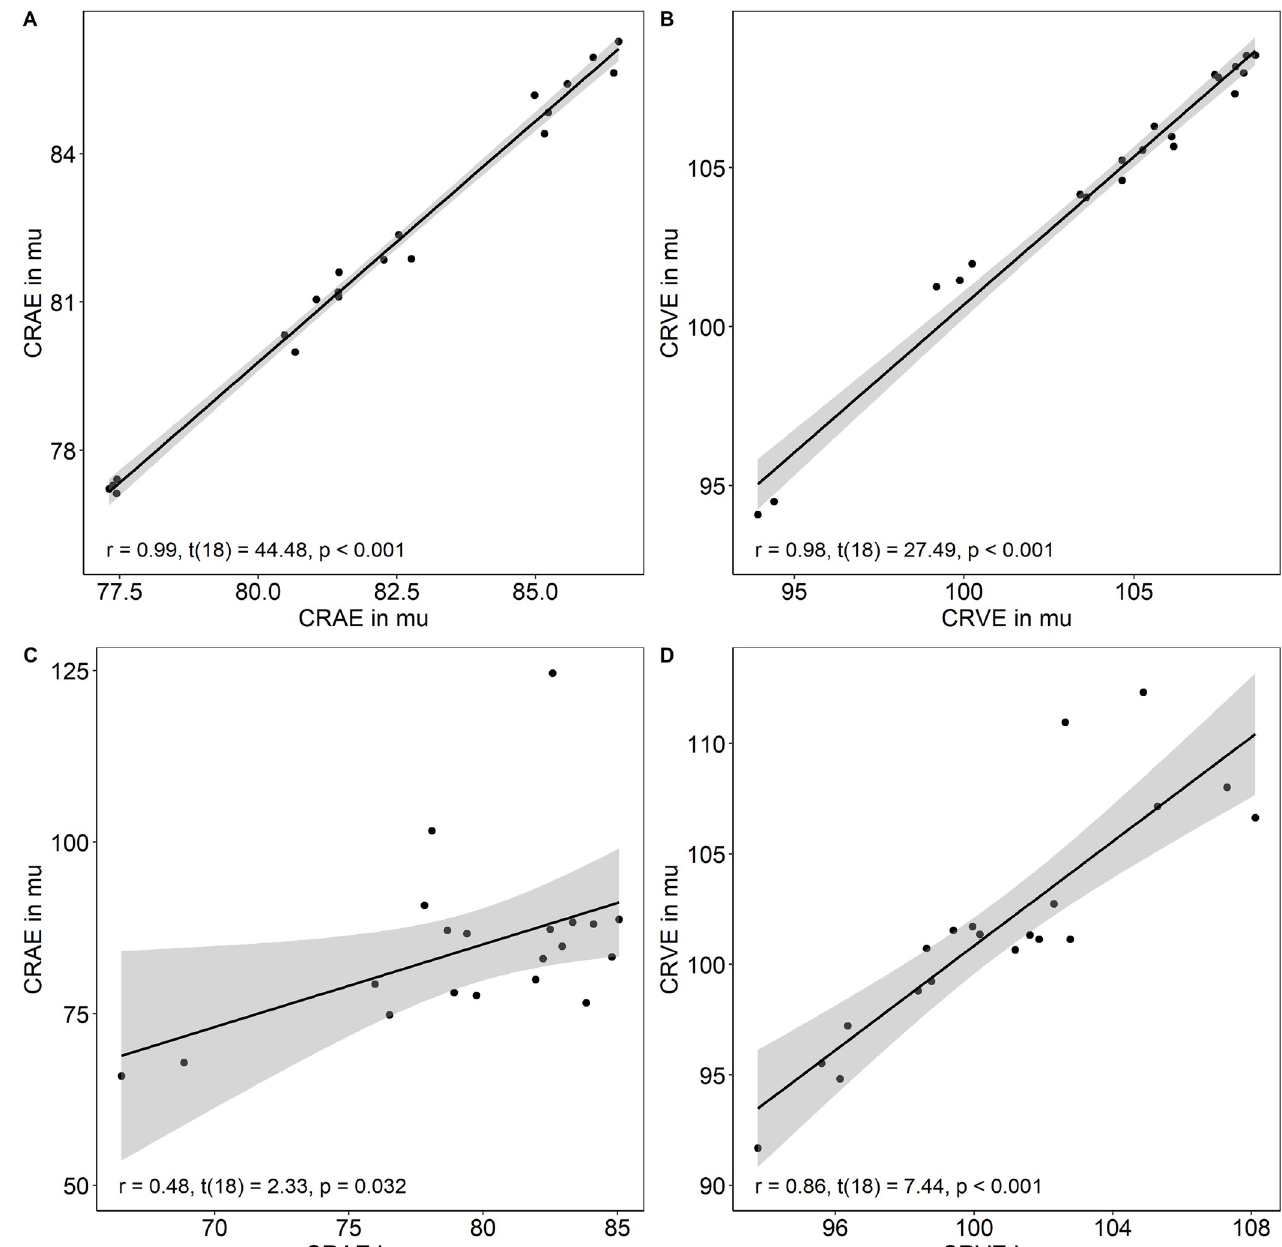
Fig 4. Intraobserver variability. Twenty images with (A and B) and 20 images without fluorescein (C and D) were analysed twice by one investigator to quantify intraobserver variability. Images were randomly selected. The intraobserver variability was analysed by calculating two-tailed Pearson correlations as well as the coefficient of variation of CRAE and CRVE